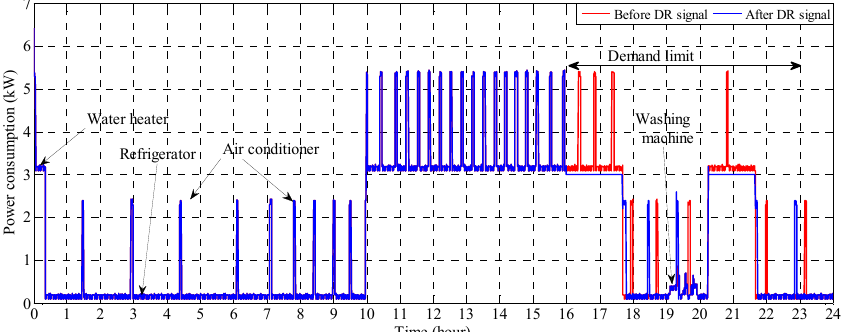
Figure 27. Total power consumption before and after DR signal with the hybrid PSO ‐ ANN.